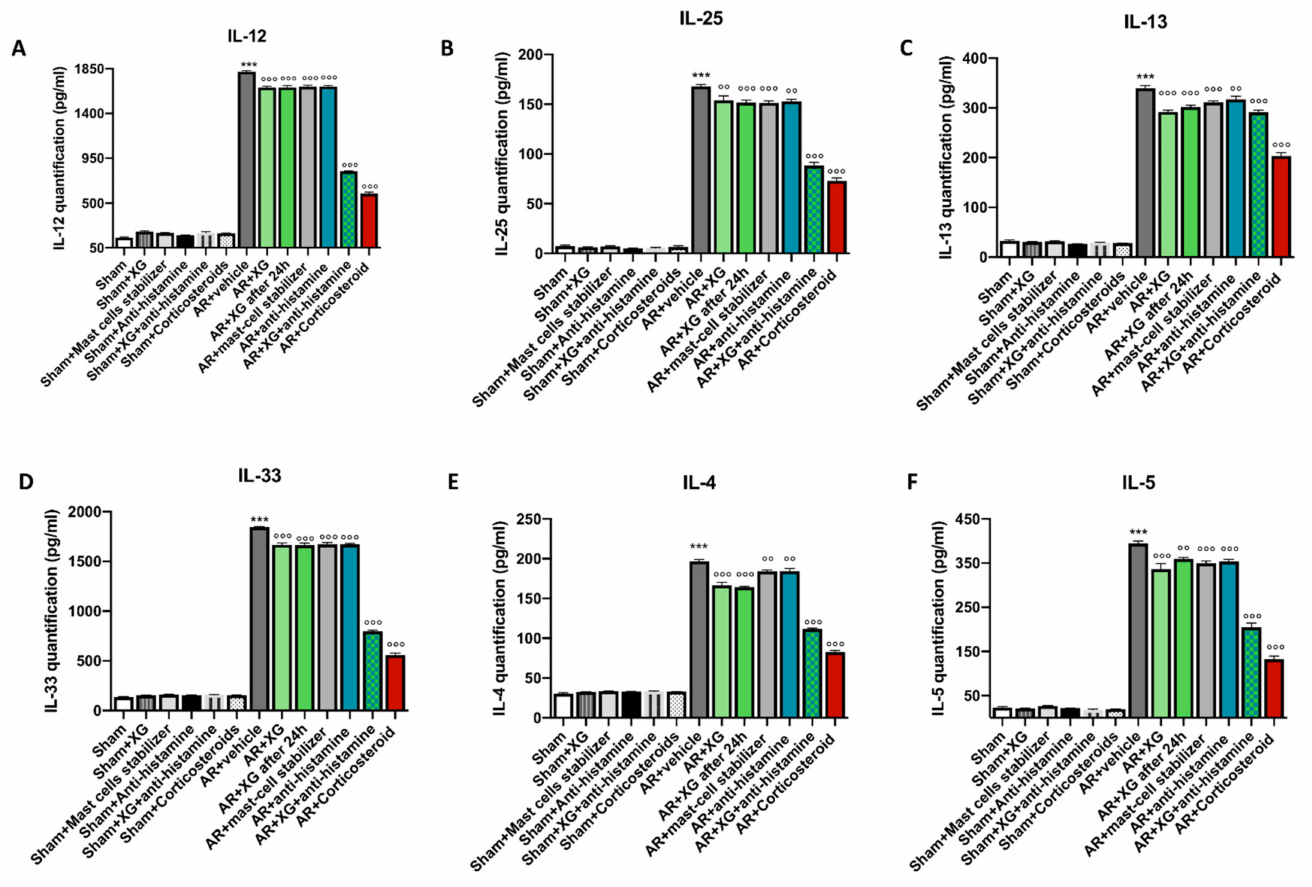
Figure 3. Effect of xyloglucan on cytokine quantification in the nasal mucosa of OVA-sensitized mice. OVA-sensitized mice exposed an extensive upregulation of cytokines in the nasal mucosa tissue, compared to the sham groups ( A – F ). However, treatment with XG based spray proved to be successful in reducing the expression of proinflammatory cytokines IL-12, IL-25, IL-13, IL-33, IL-4 and IL-5 in nasal mucosa of mice ( A – F ). This decrease was quantitatively greater when XG spray was associated with antihistamine, thus becoming comparable to the effects obtained with corticosteroid administration. Data are representative of at least three independent experiments. Values are means ± SEM. One-Way ANOVA test. *** p < 0.001 vs. Sham; ◦◦ p < 0.01 vs. AR + vehicle; ◦◦◦ p < 0.001 vs. AR +